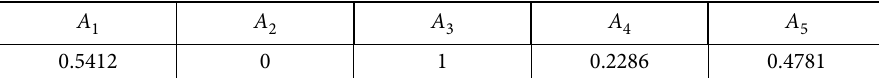
Table 17. The normalized appraisal scores of the enhancement EDAS method based on the CPT